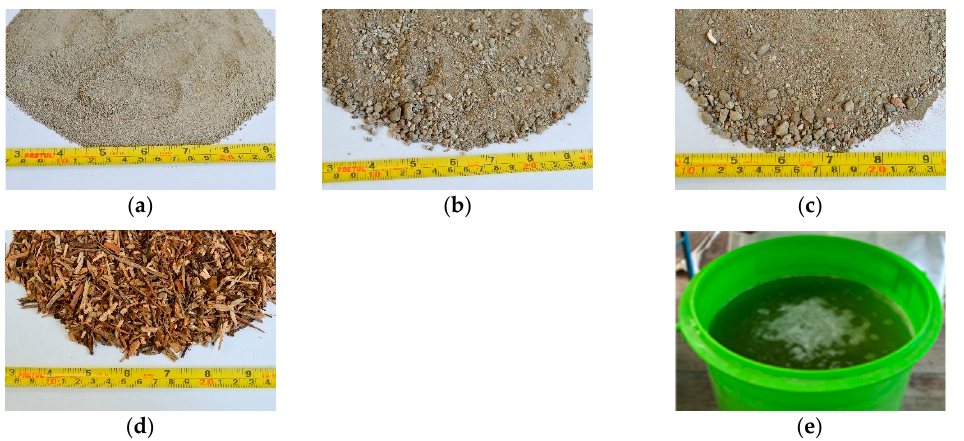
Figure 1. Materials ( a ) Excavation wastes; ( b ) only concrete (OC); ( c ) all-in-one (AiO); ( d ) Wood waste; ( e ) Mucilage and Water.